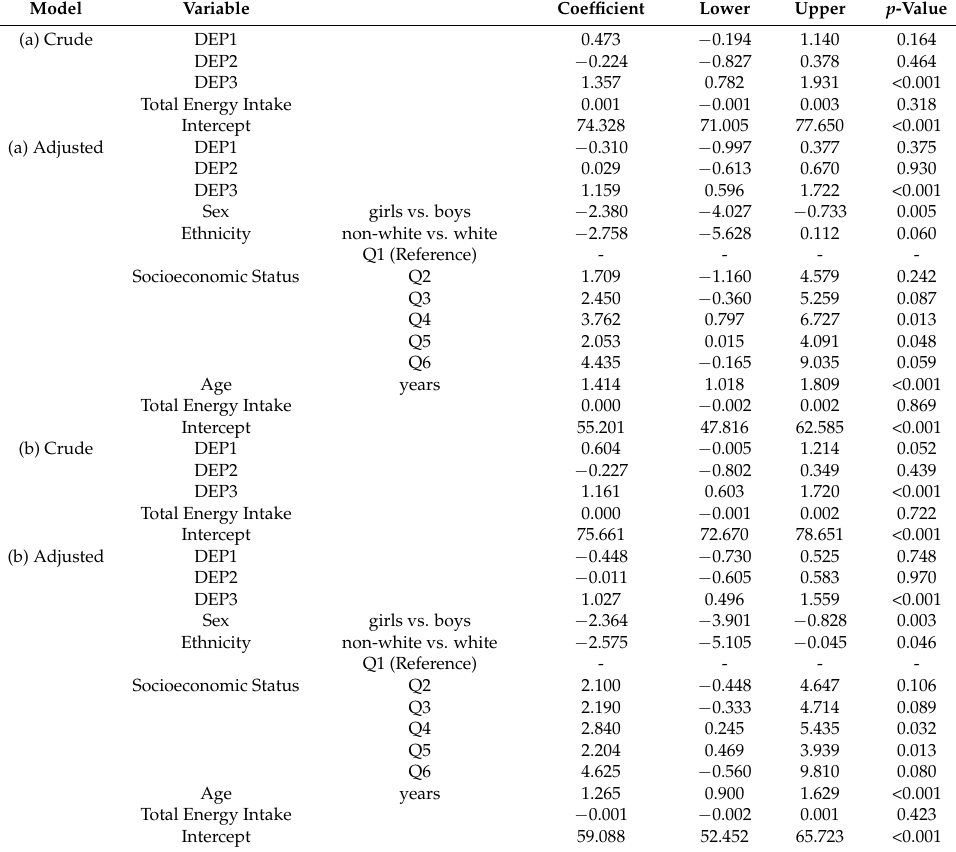
Table 4. The coefficient estimates from the complete case (a) and imputed (b) crude and adjusted multiple regression models relating diurnal eating patterns (exposures) and waist circumference (outcome), accounting for complex survey